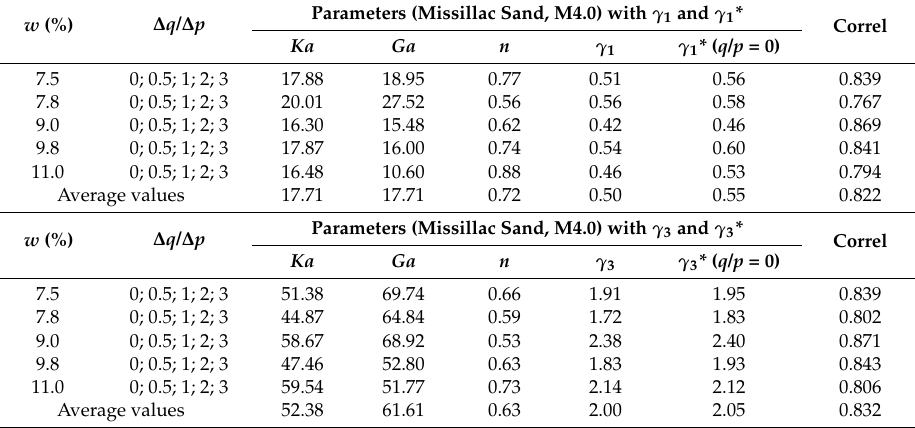
Table 4. Parameter optimization of the modified Boyce model for